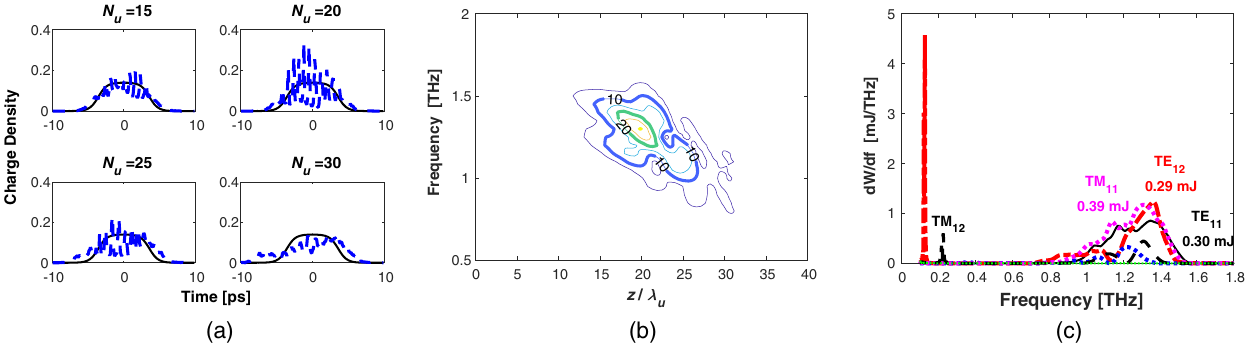
FIG. 12. Nonmodulated bunch with a charge of 5 nC, a duration of 7.1 ps, and smoothed edges in the positive mass regime (under- resonance guiding field of 33 kG): (a) charge density after 15 to 30 undulator periods, (b) contours of the bunching factor, and (c) radiation spectrum after 40 undulator